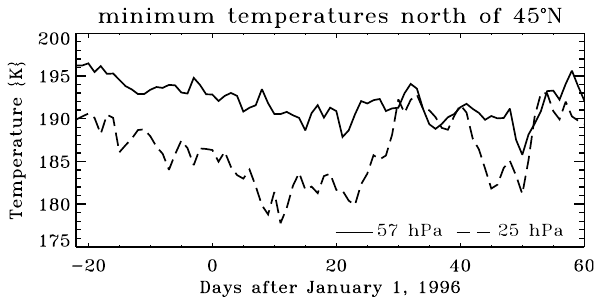
Fig. 2. Temporal change of model minimum temperatures within the area north of 45 ◦ N. Data is presented for the time period be- tween 10 December 1995, and 29 February 1996, and the model levels 57 and 25 hPa.